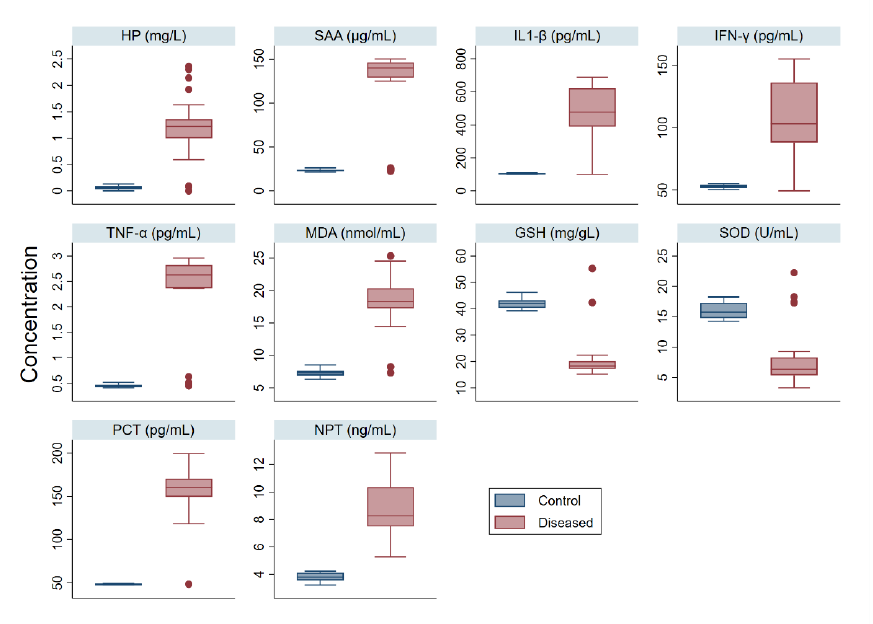
Figure 3. Box plots displaying the variability of acute-phase proteins (HP, Haptoglobin; SAA, serum amyloid A), proinflammatory cytokines (IL1- β, Interleukin one beta; IFN- γ, Interferon gamma; TNF- α, tumor necrosis factor alpha), oxidative stress markers (MDA, malondialdehyde; GSH, reduced glutathione; SOD, super oxide dismutase), procalcitonin (PCT), and neopterin (NPT) in the serum of diarrheic calves naturally infected with C. parvum ( n = 57) and healthy control calves ( n = 20). A difference with p < 0.05 was considered significant.